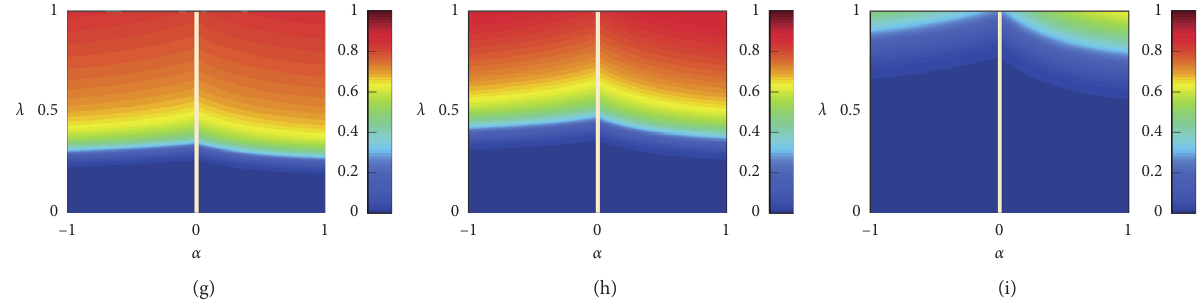
Figure 5: The theoretical outbreak size R ( ∞ ) as a function of resource providing parameter α and transmission probability λ on the scale- free network with β � − 1 (a) (d) (g), β � 0 (b) (e) (h), and β � 1 (c) (f) (i). (a)–(c) ( f � 0 . 03), (d)–(f) ( f � 0 . 05), and (g)–(i) ( f � 0 . 1). Colors represent the values of R ( ∞ ) . The white dotted line in each subgraph indicates the optimal value of α k � 100, and c � max